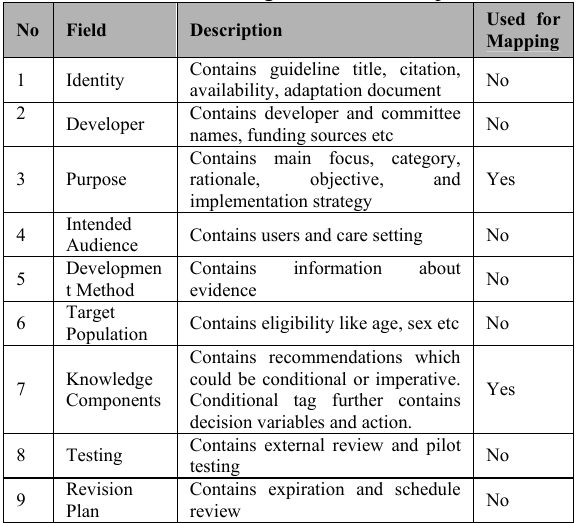
Table 1: GEM tags and their